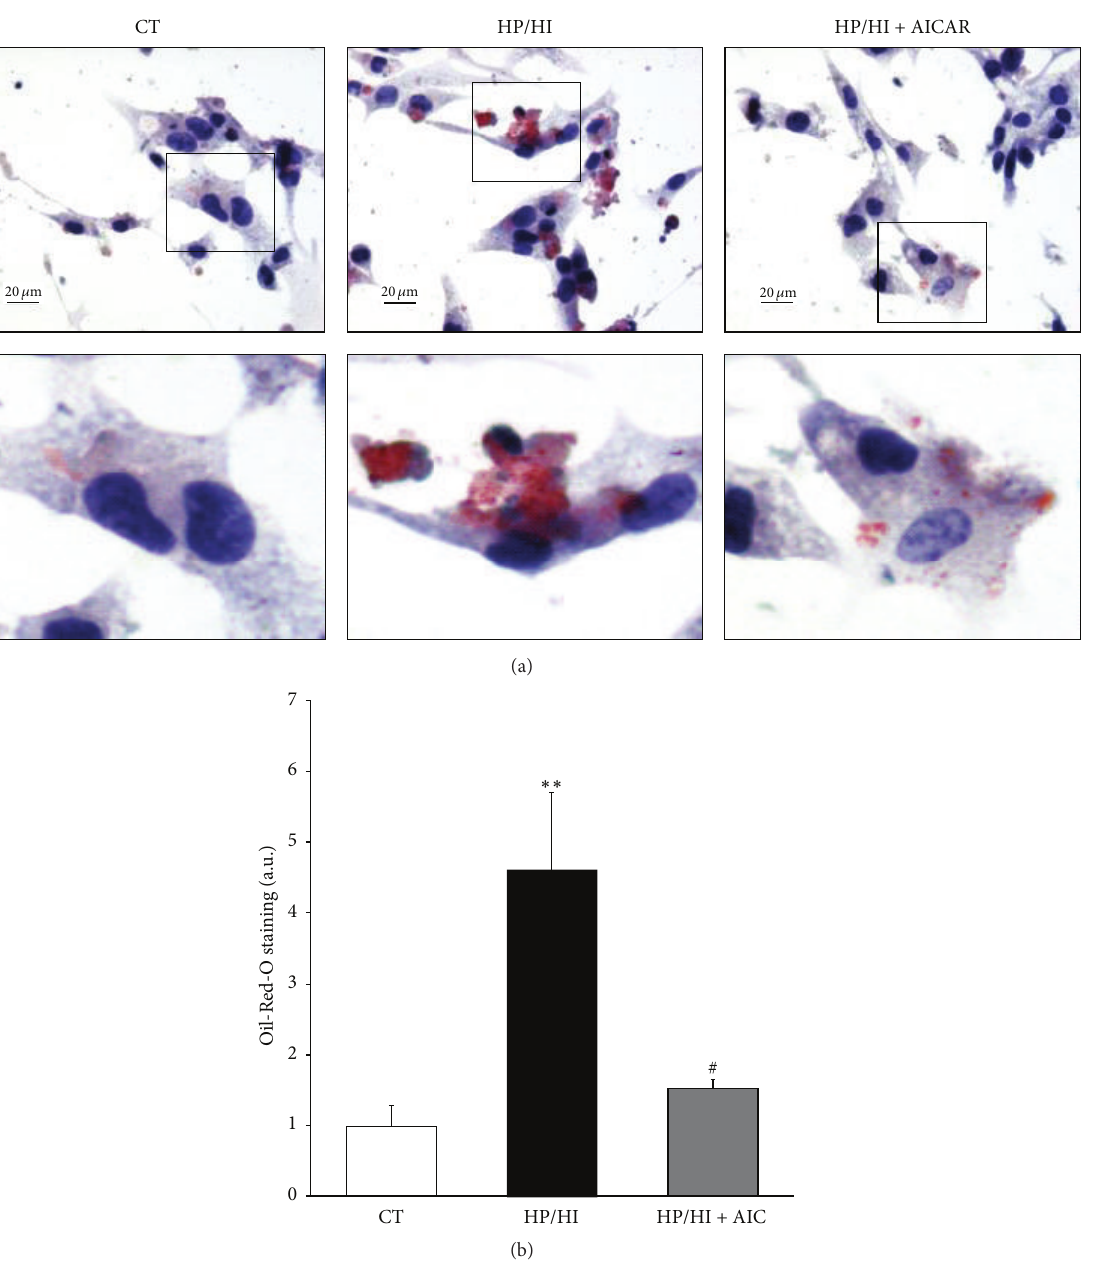
Figure 4: AICAR prevents the HP/HI-induced intramyocellular lipid accumulation in HL-1. Lipid content was analyzed by Oil-Red- O staining in HL-1 challenged with HP/HI for 16h in the presence or absence of AICAR (24 h). (a) Representative microphotography showing lipid droplets in cells counterstained with Haematoxylin (bar 20 𝜇 m). Squares indicate the areas shown at high magnification. (b) Quantification of stained areas relative to cell surface. Data are expressed as mean ± SD of 5 different pictures from 3 independent experiments ( ∗∗ 𝑃 < 0.01 versus control nonstimulated cells; # 𝑃 < 0.05 versus HP/HI-stimulated